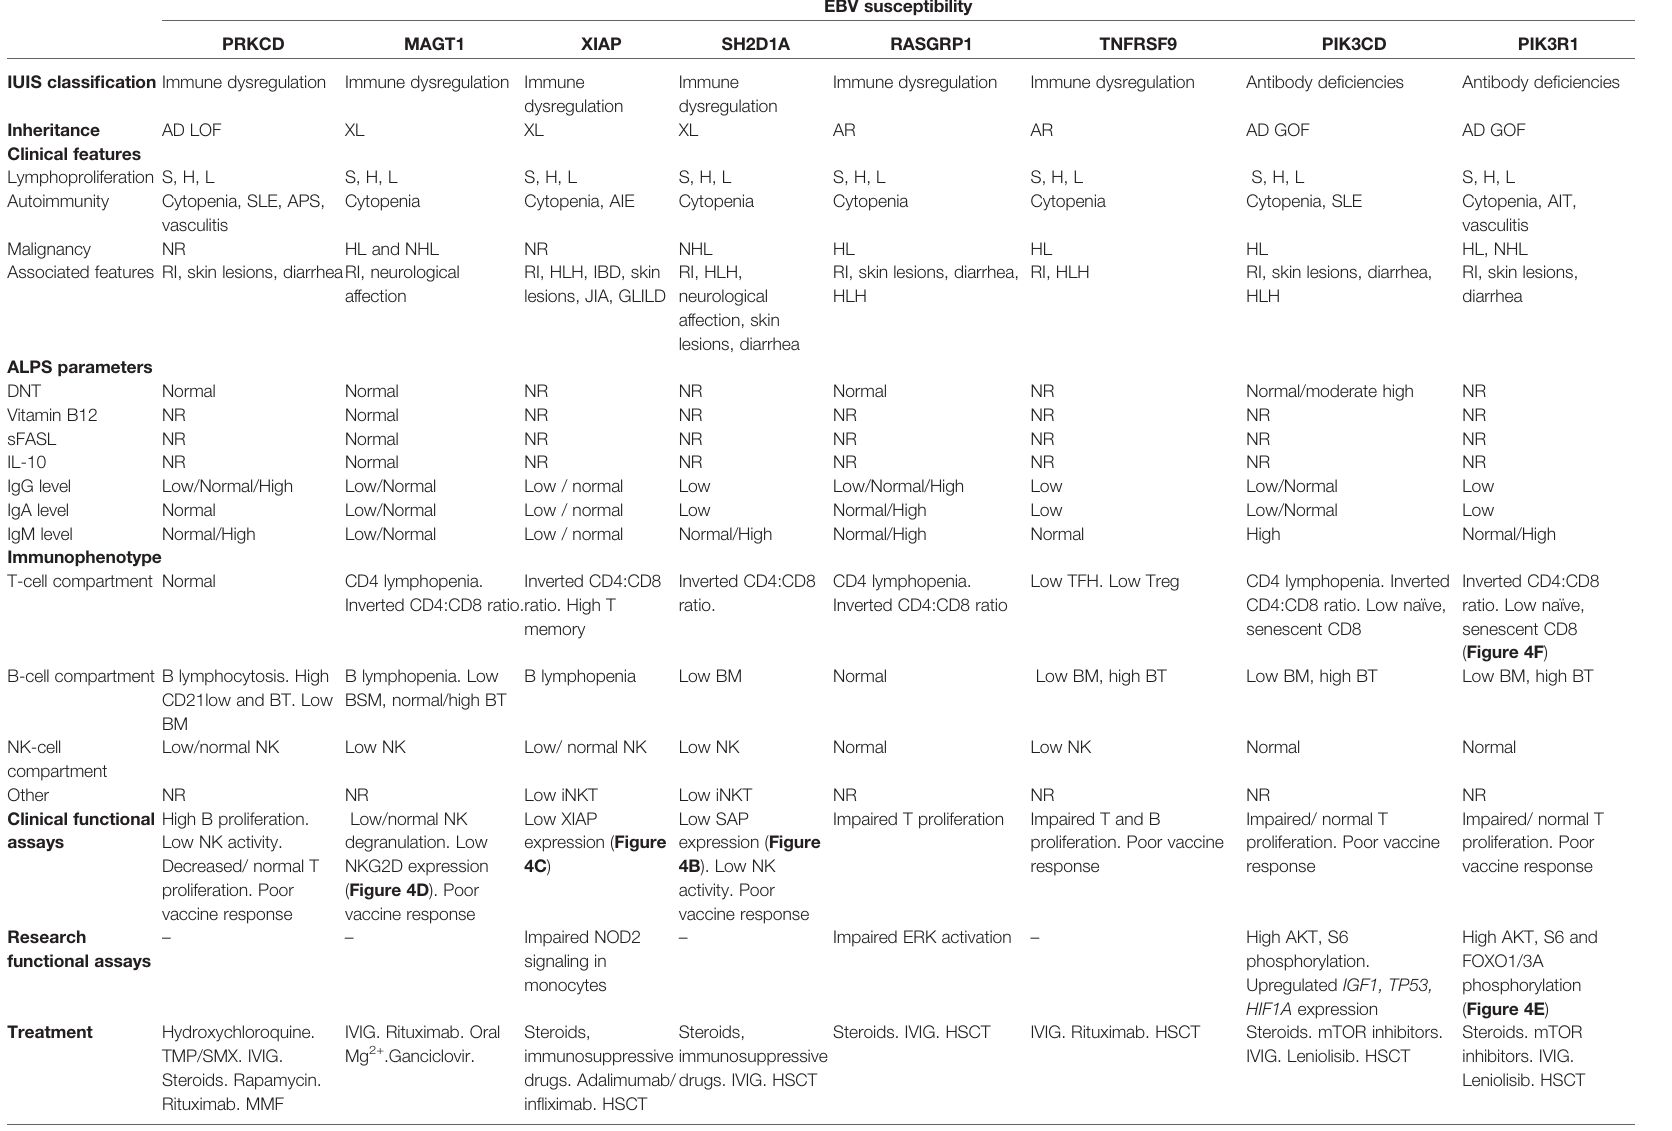
TABLE 1 | Clinical and laboratory features of ALPS-like